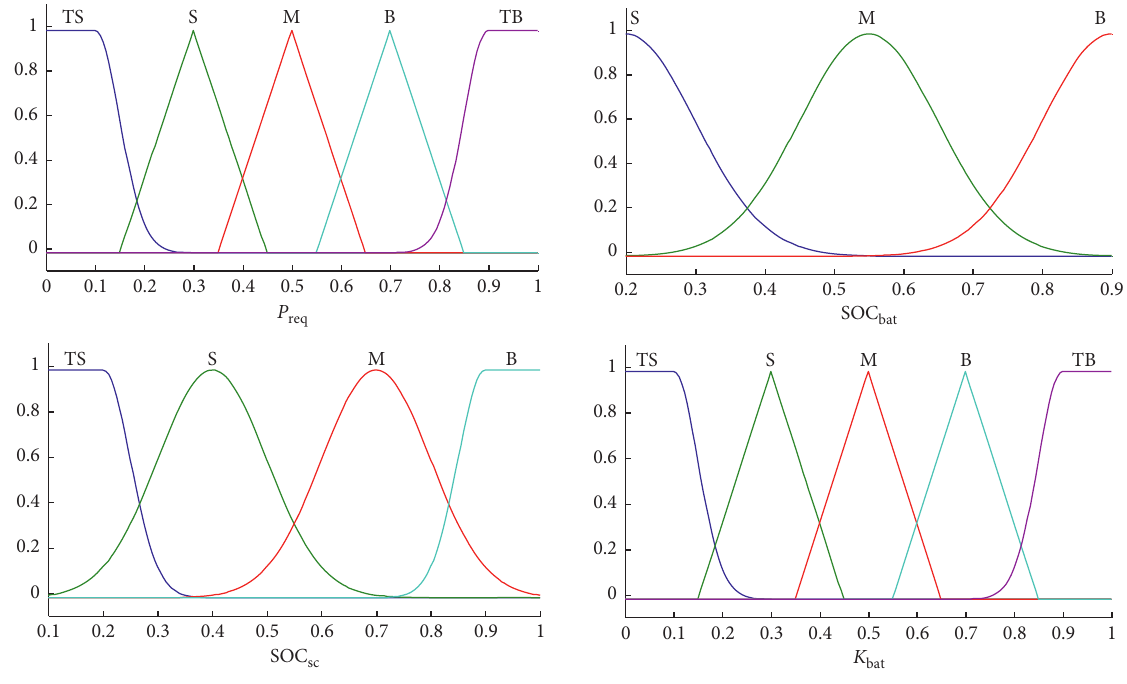
Figure 5: Membership function of fuzzy variables. Table 4: Fuzzy rules in charge mode.